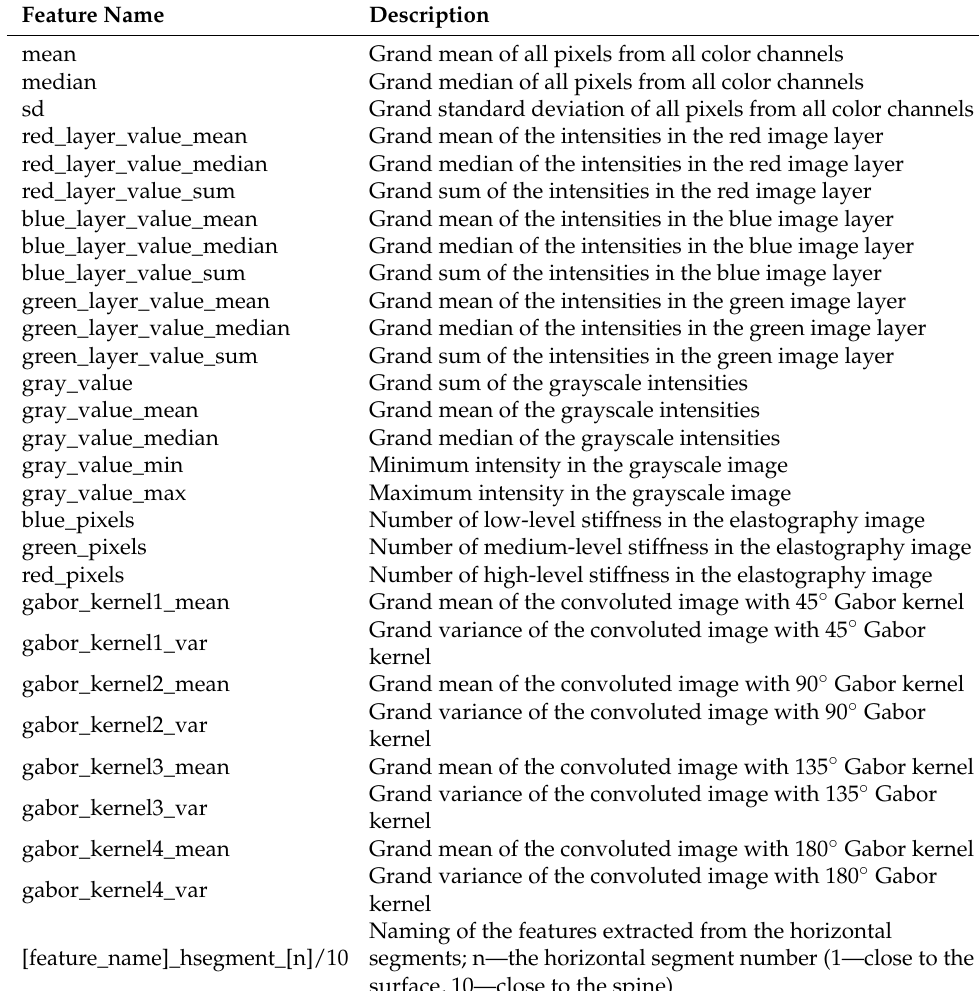
Table 2. The description of the features used in the training of machine learning